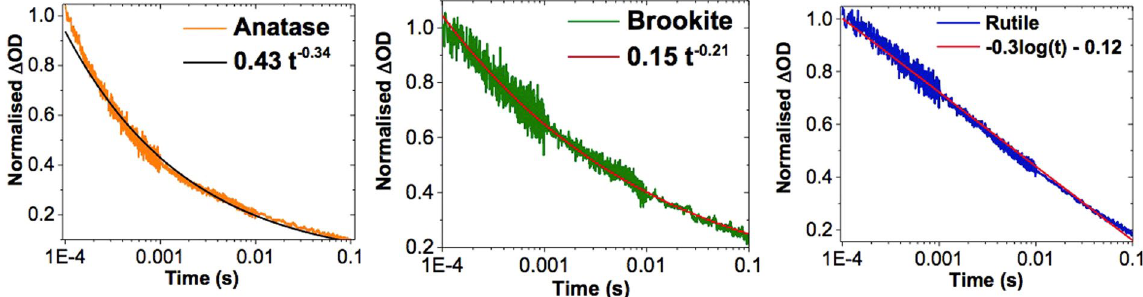
Figure 3. Normalised TA decays of mesoporous anatase at 600 nm (left), brookite at 650 nm (middle) and rutile at 650 nm (right) under an inert atmosphere. These are shown alongside the best fitting equation for each decay. Under an inert atmosphere, the normalized decay kinetics for a given polymorph match at all wavelengths. Consequently, decays corresponding to wavelengths with the highest signal to noise ratio are